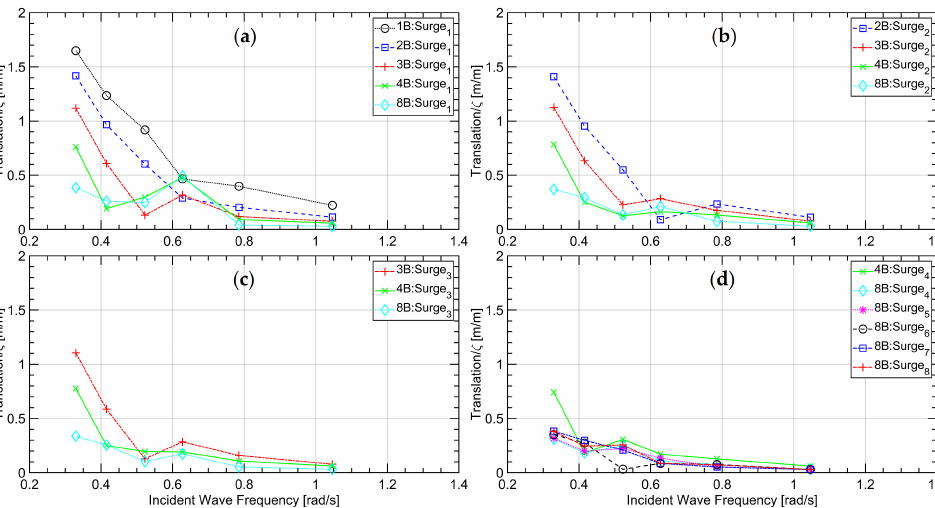
Figure 6. RAOs of surge response of the five test cases for the chain configuration, where n B denotes the configuration with n bodies; subscript n , the corresponding n -th body’s motion response: ( a ) the 1st module; ( b ) the 2nd module; ( c ) the 3rd module; ( d ) the 4th–8th modules.